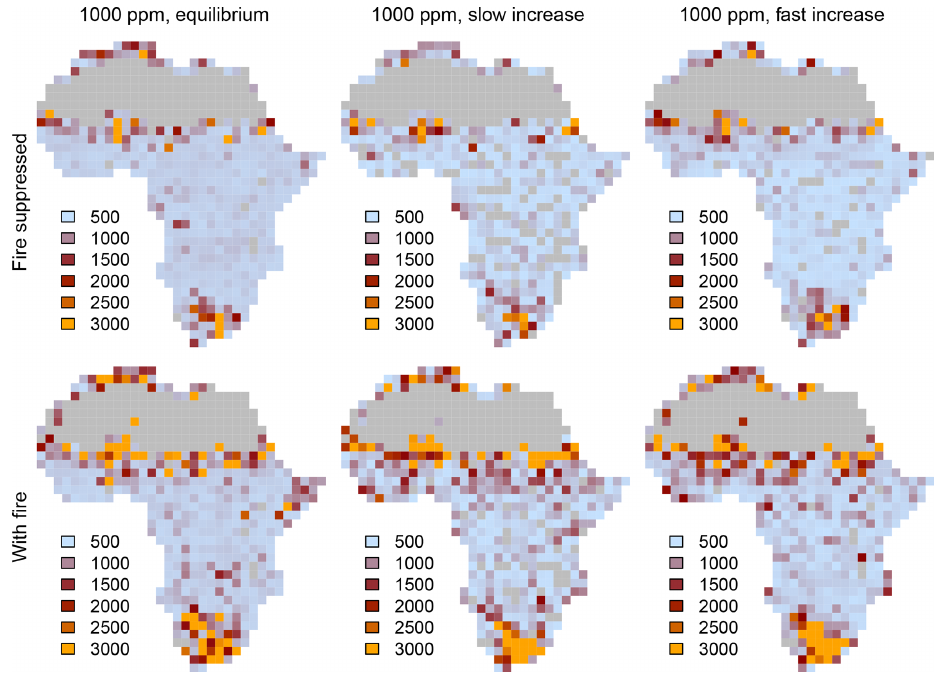
Figure 5. Time required to reach equilibrium in equilibrium simulations and transient simulations with both slow and fast increases in CO 2 . Note that 3000 years in the legend means ≥ 3000 years, because simulations were run for a maximum of 3000 years.